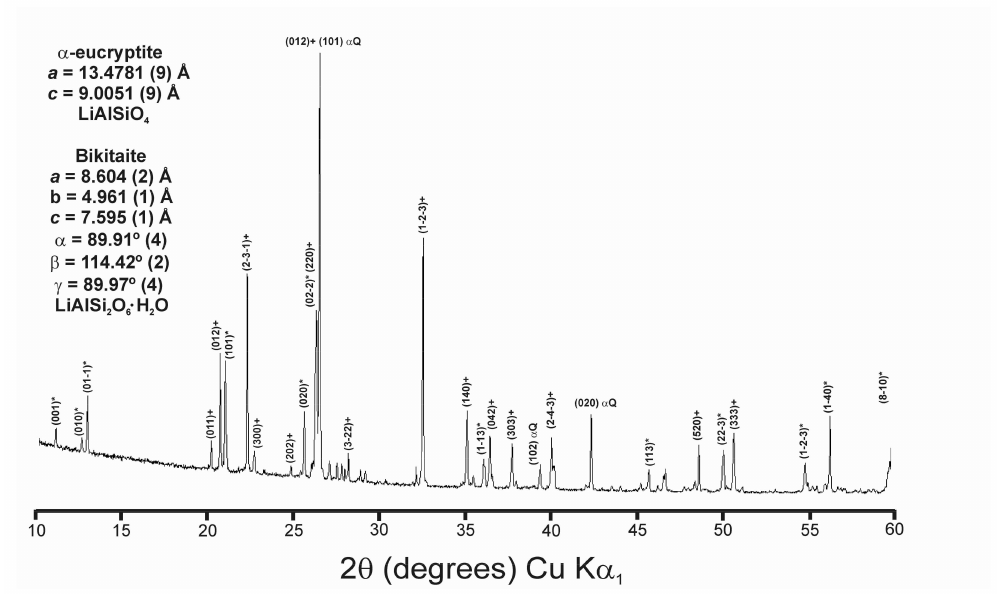
Figure A3. Powder XRD pattern of α -eucryptite LiAlSiO 4 with a = b = 13.4781 (9) Å, c = 9.0051 (9) Å, α = β = 90 ◦ , and γ = 120 ◦ with some (hkl)* from the R -3 space group, very similar to CC 30983 [57] with a = b =13.471 (3) Å, c = 8.998 (2) Å, α = β = 90 ◦ , and γ = 120 ◦ ; and bikitaite LiAlSi 2 O 6 · H 2 O with a = 8.604 (2) Å, b = 4.961 (1) Å, c = 7.595 (1) Å, α = 89.91 ◦ (4), β = 114.42 ◦ (2), and γ = 89.97 ◦ (4), with some (hkl)+ from a P 1 space group, very similar to CC 68586 with a = 8.6071 (9) Å, b = 4.9540 (5) Å, c = 7.572 (7) Å, α = 89.900 ◦ (7), β = 114.437 ◦ (8), and γ = 89.900 ◦ (7) [38], with some quartz diffractions used as internal standard, from specimen Bikita. The Rietveld quantification of these three mineral phases is: α -eucryptite 52.1 wt %, bikitaite 19.8 wt %, and α -quartz 28.1 wt %.